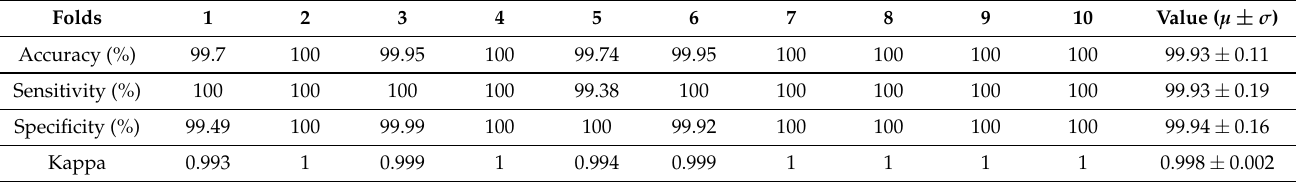
Table 5. Results obtained using multi-channel multi-scale deep CNN with 10-fold